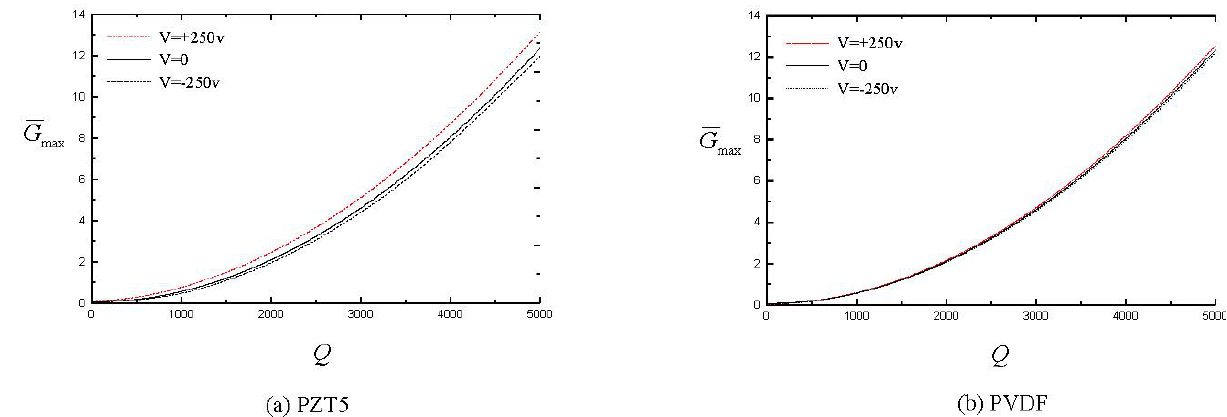
Figure 7. Effect of voltage on ¯ G max of delaminated piezoelectric shell